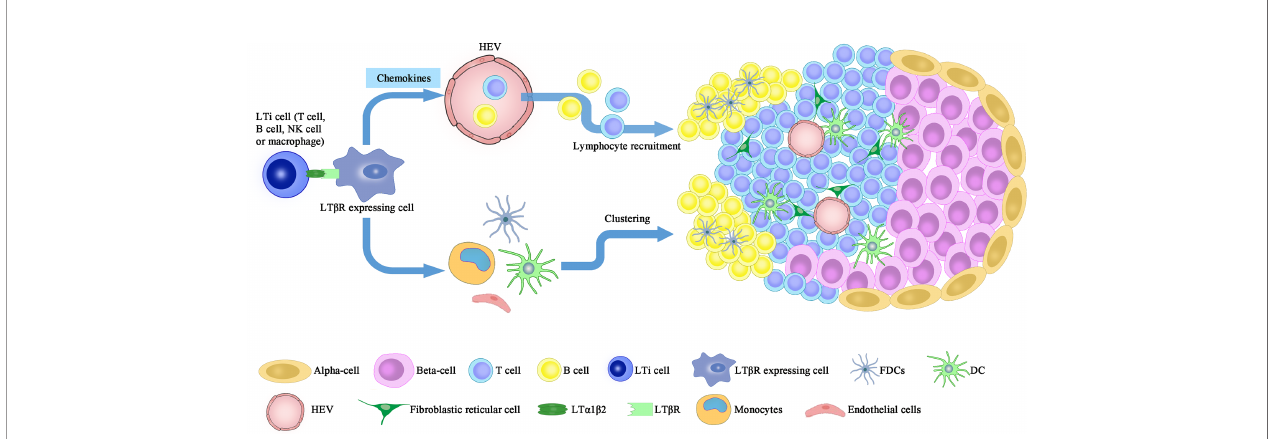
FIGURE 1 | LT signaling participates in the formation of peri-islet TLO. Neogenesis of peri-islet TLO is orchestrated by the interaction between LT a 1 b 2 expressing cells, including LTi, NK, B cells and activated T cells, and the LT b R expressing cells (FDCs, DCs, monocytes and stromal cells). This interaction induces islet in fi ltration of lymphocytes, which are then clustered into organized TLOs and contribute to b cell destruction. LTi, lymphoid tissue inducer; FDC, follicular dendritic cells; HEV, high endothelial